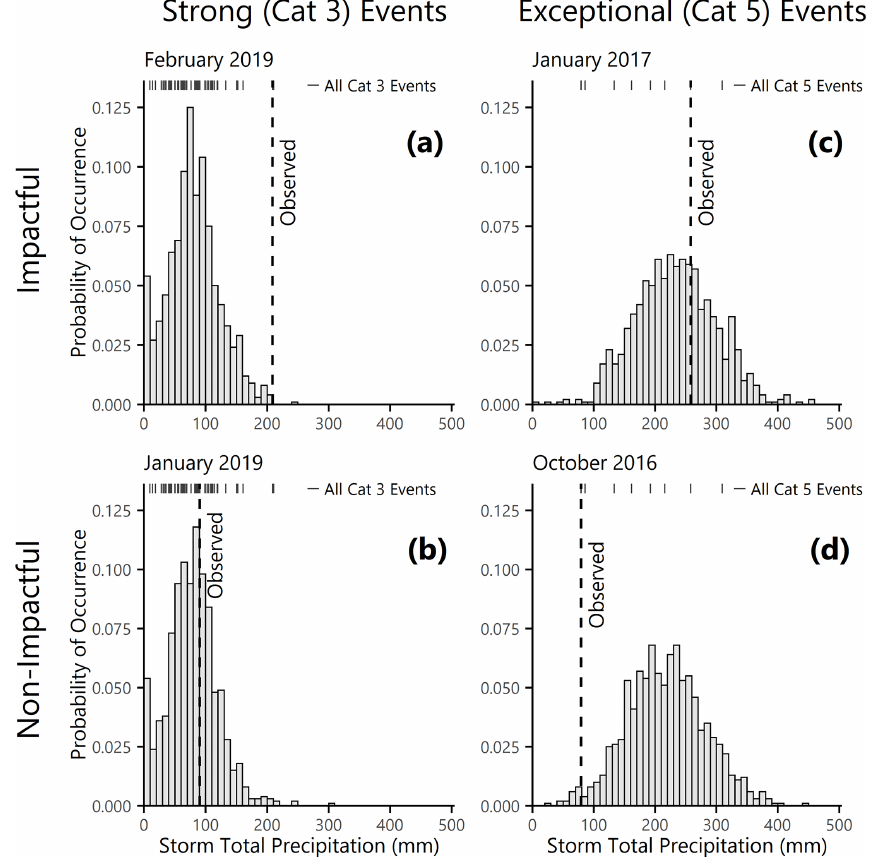
Figure 5. Precipitation realizations for case study events. Distribution of simulated precipitation realizations including uncertainty for AR events occurring in (a) February 2019, (b) January 2019, (c) January 2017, and (d) October 2016. Events are labeled by their Ralph et al. (2019) intensity category (panels (a) and (b) vs. panels (c) and (d) ) and impact level (panels (a) and (c) vs. panels (b) and (d) ). The observed precipitation for each event is marked by a vertical dashed line, and the tick marks along the top of each panel show how the observed values compare with precipitation totals from other AR events in the same intensity